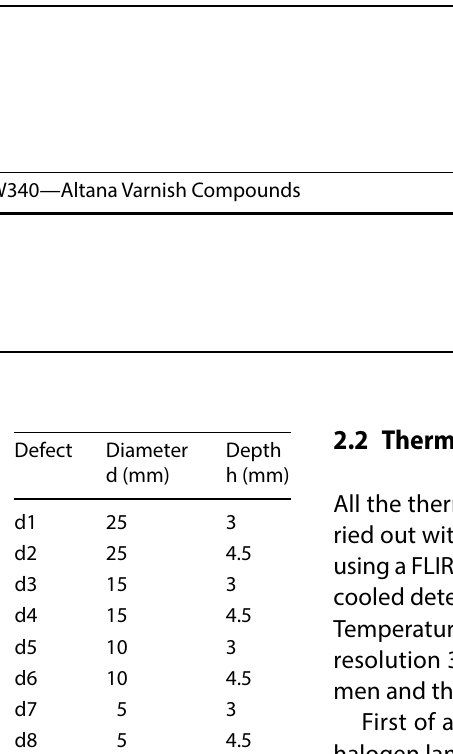
Table 1 Mechanical and physical properties of glass fibre and epoxy resin E-glass fibre—Selcom Multiaxial Technology srl